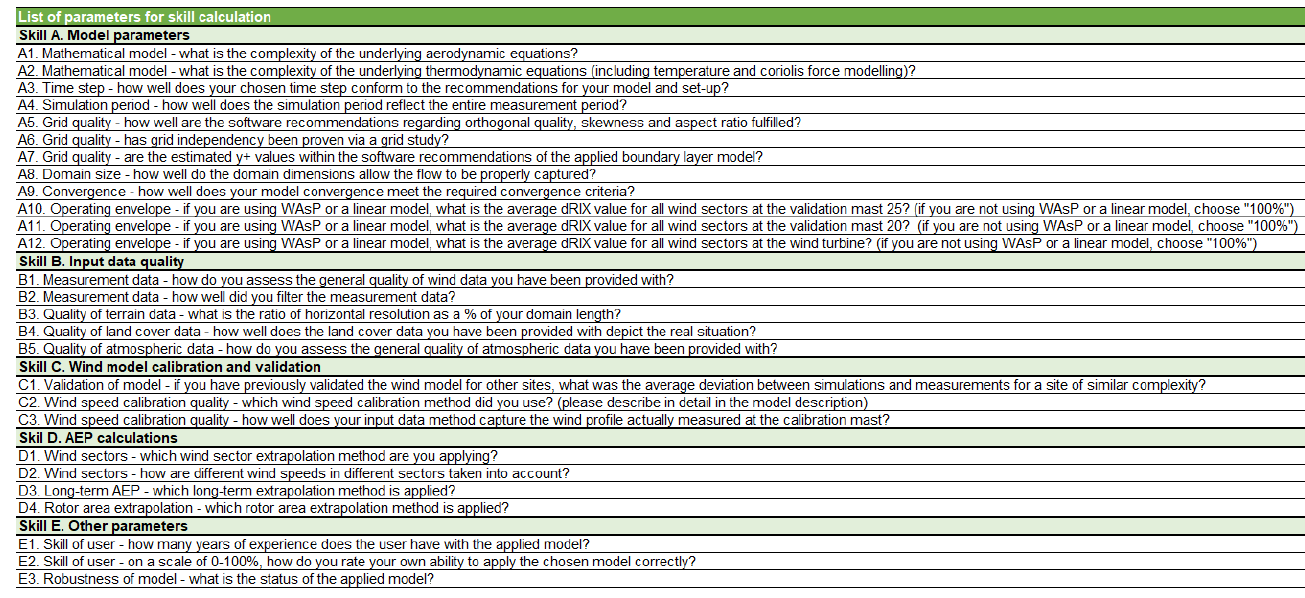
Figure 3. List of skill and cost parameters.